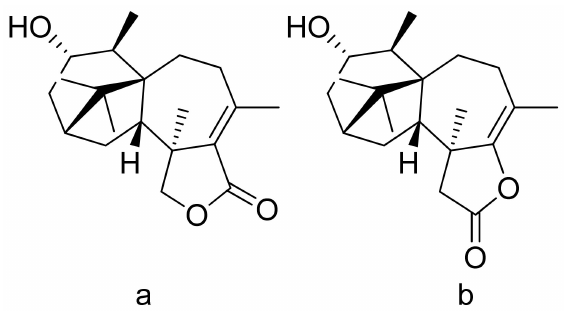
Figure 21. Harzianelactones A ( a ) and B ( b